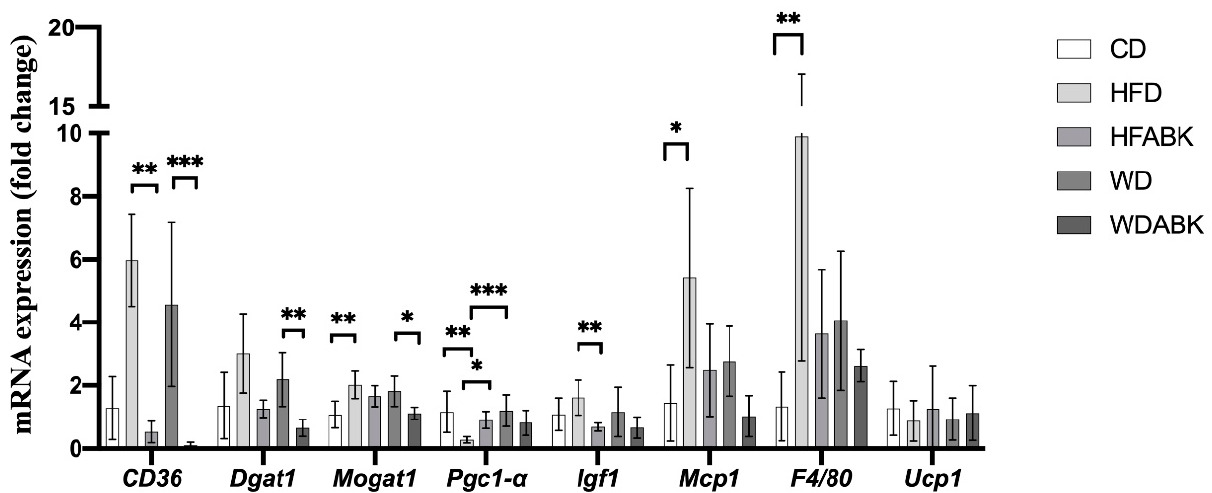
Figure 5. mRNA expression of adipogenesis- and inflammation-related genes in eWAT from HFD- and WD-fed mice. Data are expressed as mean ± SD. * p < 0.05, ** p < 0.01, *** p < 0.001. (n = 8 per group) Statistics were analyzed by using Kruskal–Wallis test with a post hoc Dunn’s multiple comparison test.